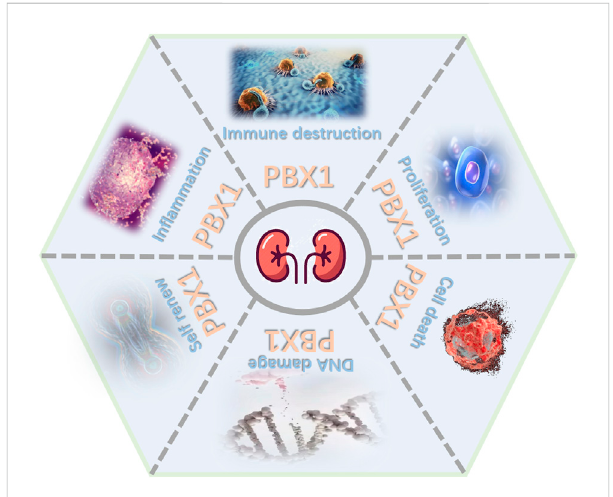
FIGURE 1 Major roles of PBX1. PBX1 contributes to kidney development, tumor progression, and blood vessels by interfering in proliferation, cell death, self-renewal, DNA damage, in fl ammation, and immune destruction ( fi gure was modi fi ed from Servier Medical Art (http://